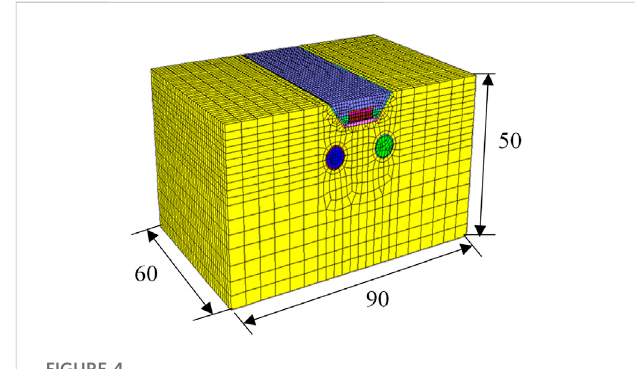
FIGURE 4 Diagram of model (unit: